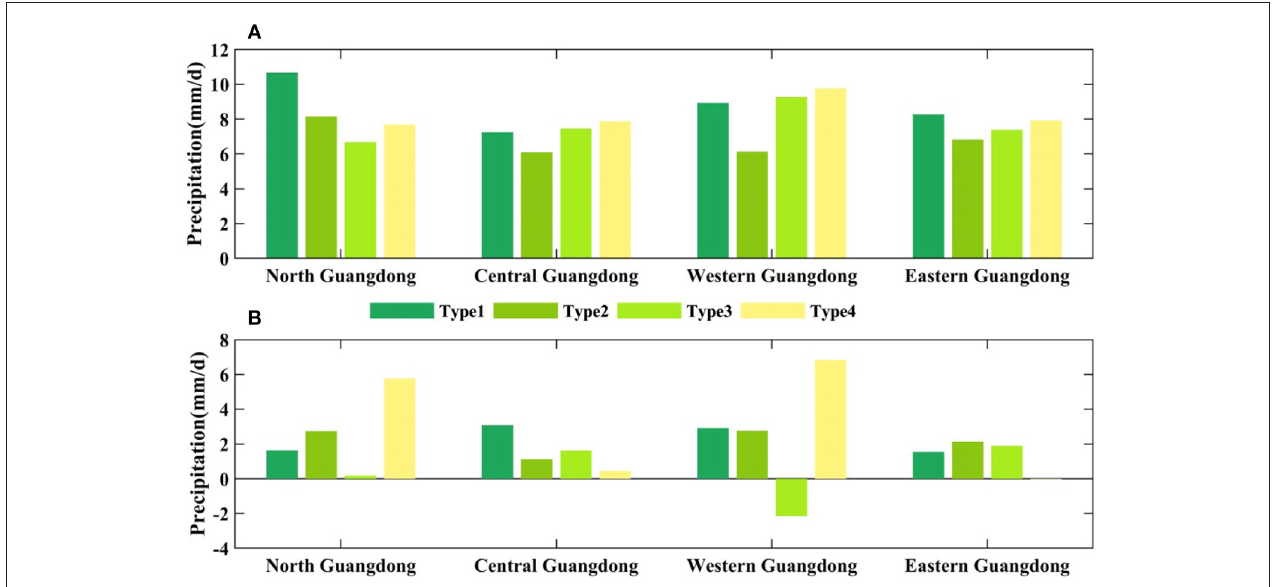
FIGURE 11 | (A) Bar graphs of daily precipitation for the four weather patterns in northern, central, western and eastern Guangdong (B) Difference in daily precipitation between urban and rural areas under the four weather patterns in northern, central, western, and eastern Guangdong (precipitation difference = urban precipitation minus rural